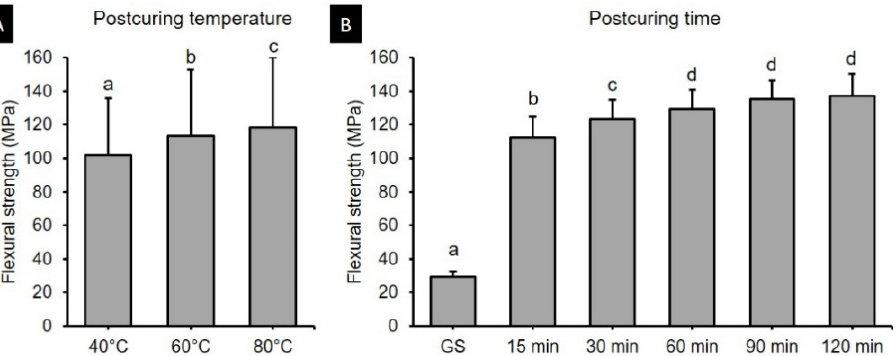
Figure 3. Results from two-way ANOVA. Flexural strength according to postcuring ( A ) temperature and ( B ) time. Data are mean and standard-deviation values of 3D printed specimens. Different lowercase letters indicate a significant difference.